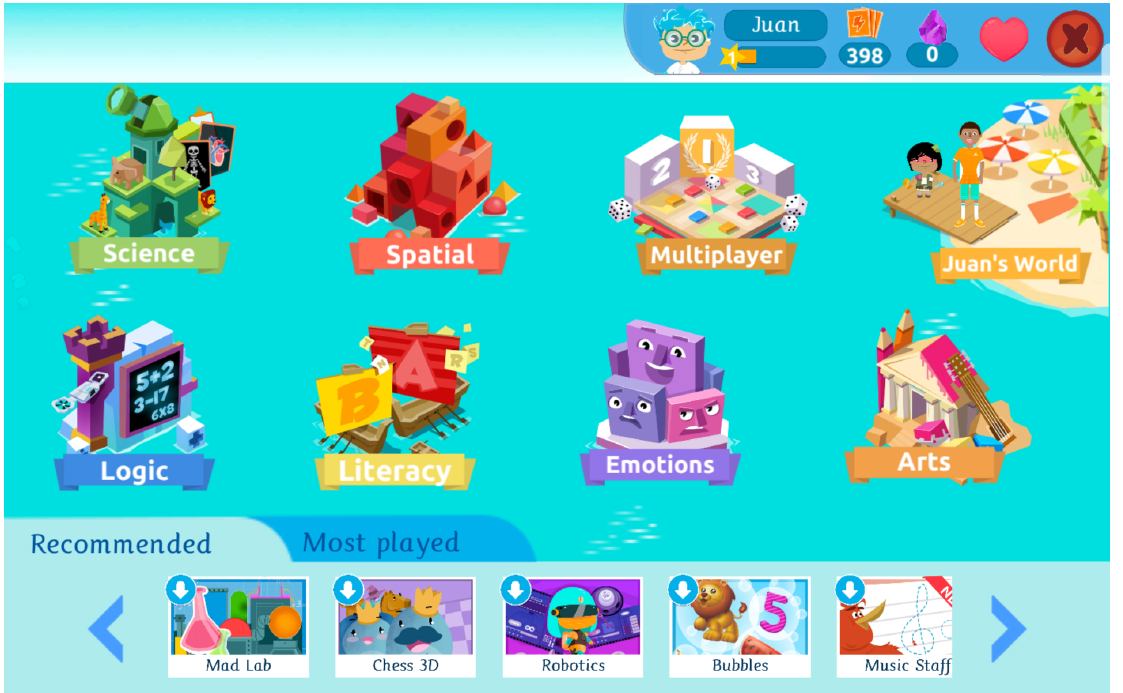
Figure 1. Screenshot of the main menu of Smile and Learn, showing the different worlds available in the application, each world corresponding to an intelligence.